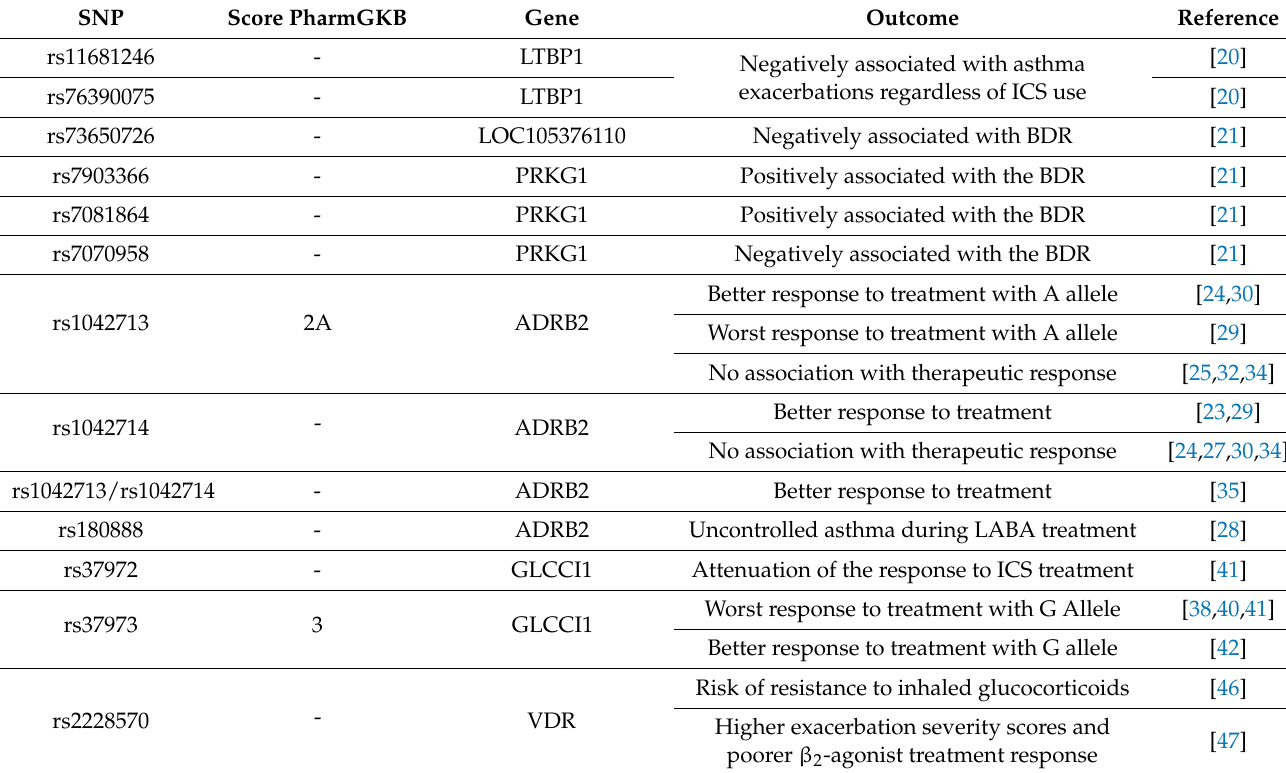
Table 1. Characterization of the single-nucleotide polymorphisms (SNPs) described in recent pharmacogenetic studies of the therapeutic response to bronchodilators or inhaled corticosteroids in asthma. SNP Score PharmGKB Gene